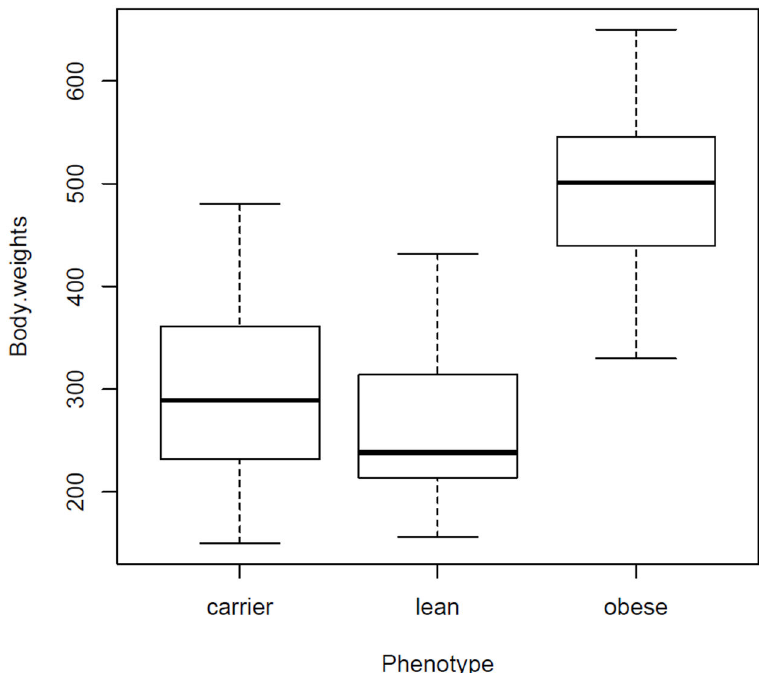
Figure 1. Boxplot showing distribution of body weights in the three phenotypes of F Carrier(n=151) and